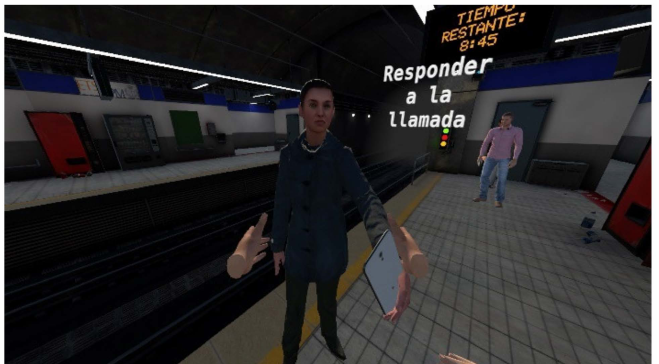
Figure 6. Character offering a mobile phone device, which needs be picked up by the user in order to activate the speech recognition to call the emergency